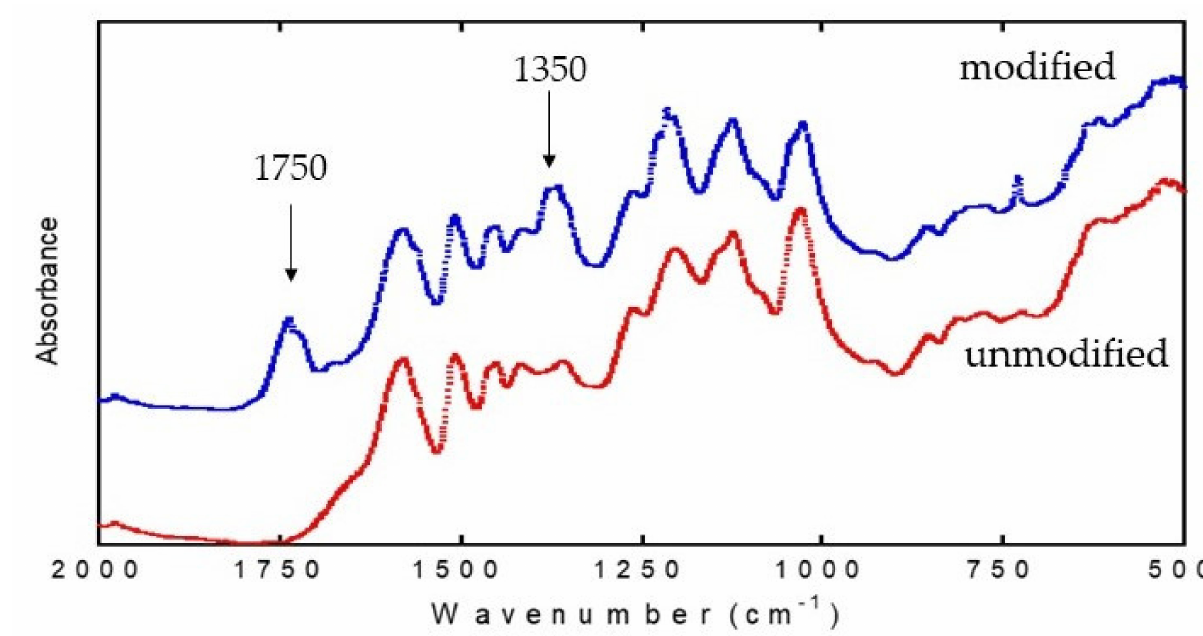
Figure 1. ATR-Fourier-transform infrared spectrometer (FTIR) of unmodified (red) and esterified lignin (blue).